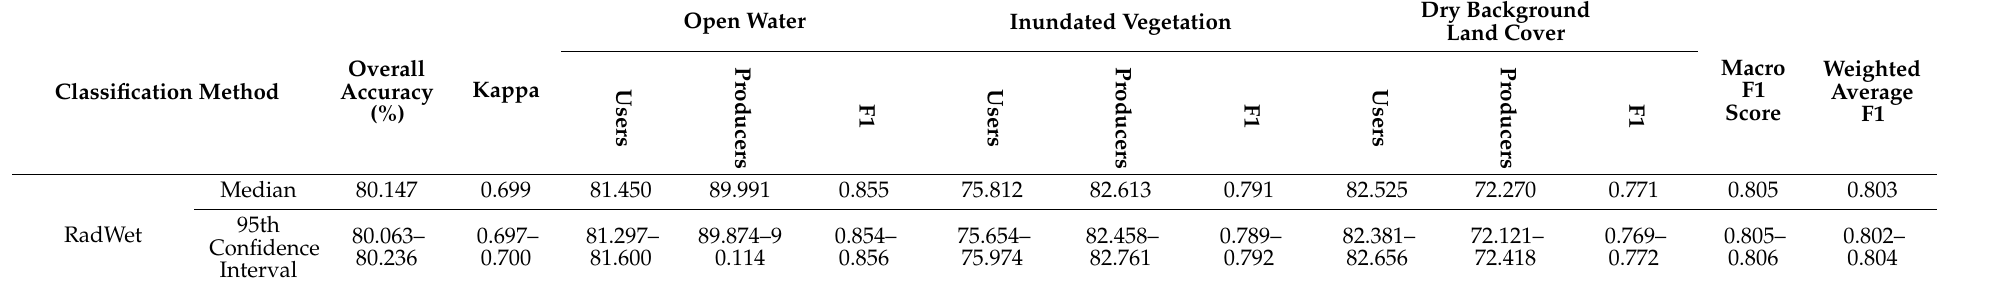
Table 5. Summary of accuracy assessment statistics for the Rupununi Wetlands in